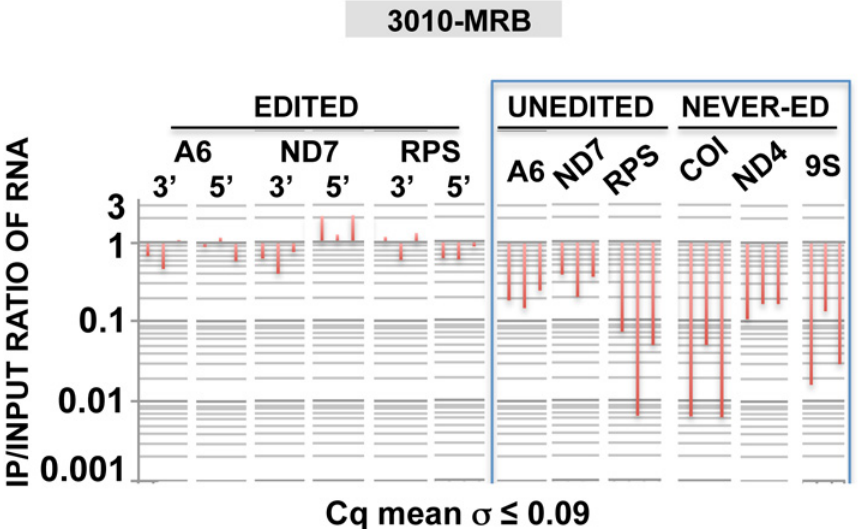
Fig 5. REH2 knockdown decreases the content of unedited pre-mRNAs in 3010-MRB. The ratio of select transcripts in IP samples and mitochondrial extract input (IP/input) was determined. Each RNA transcript was scored by RT-qPCR at days 3, 4 and 5 of REH2 RNAi. Uninduced ratios are set at 1. Standard deviation of the average value of Cq duplicates is shown. All amplicons were validated by cloning and sequencing. 18S rRNA in lysates and beads was used as